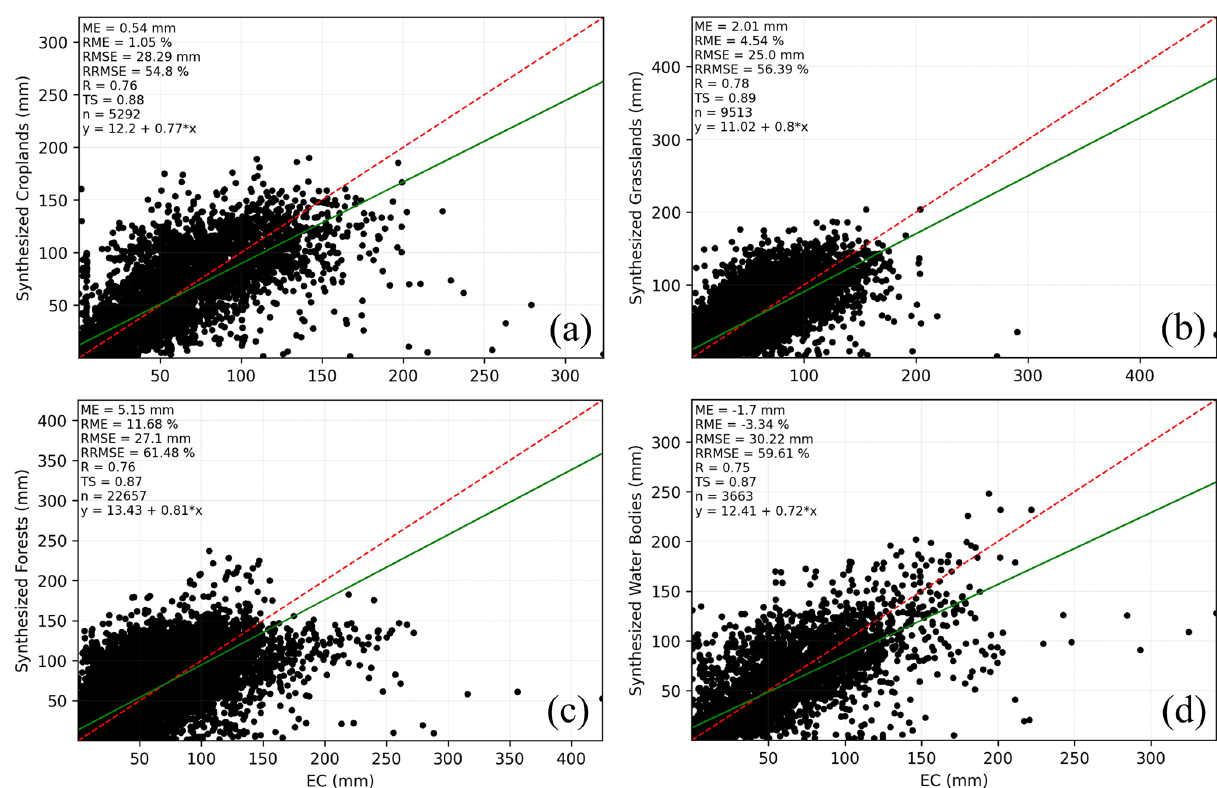
Figure 16. Monthly synthesized ET against flux EC ET aggregated for all sites for each land cover type (croplands: a ; grasslands: b ; forest: c ; water bodies: d ).